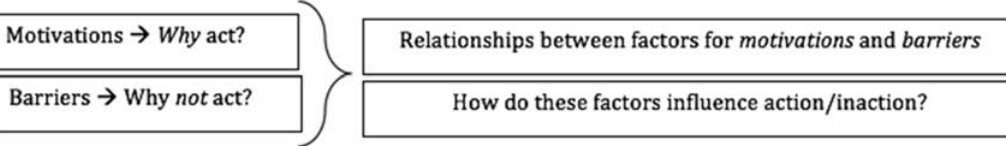
Figure 1. Conceptual framework for activist motivations and barriers to action.